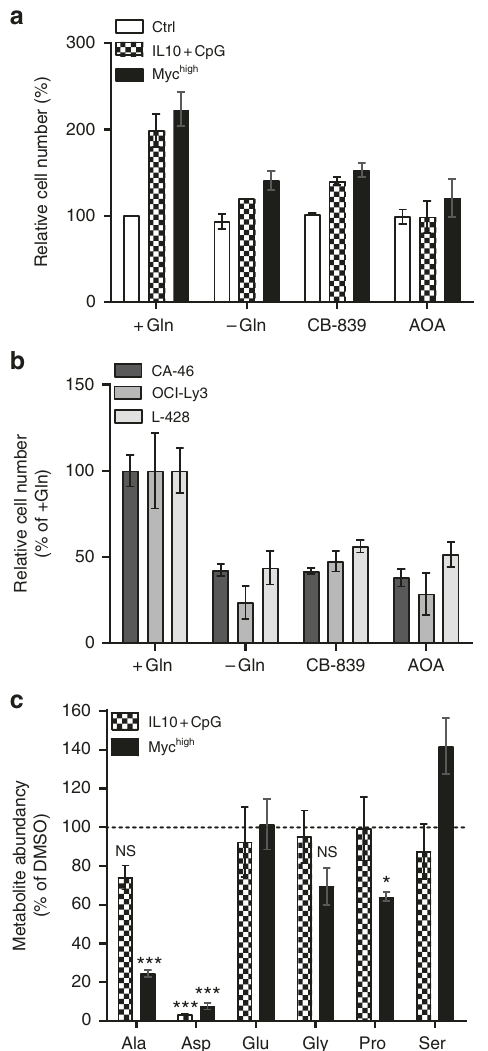
Fig. 3 Proliferation of P493-6 and B-cell lymphoma cells requires transaminase activity. a Inhibition of cell doubling of IL10 + CpG-stimulated P493-6 MYC low and P493-6 MYC high cells after 24 h of treatment with CB- 839 or AOA. b Inhibition of cell doubling of the B-cell lymphoma cell lines CA-46, OCI-Ly3, and L-428 using CB-839 or AOA treatment for 24 h. c Intracellular amino acid abundance in IL10 + CpG-stimulated MYC low and MYC high cells 24 h after AOA treatment and stimulation. For each amino acid data were normalized relative to the corresponding values of DMSO- treated cells. For all plots, error bars represent mean ± SD of three independent experiments and results from Bonferroni post hoc tests on a one-way ANOVA are given (* p < 0.05, ** p < 0.01, *** p <